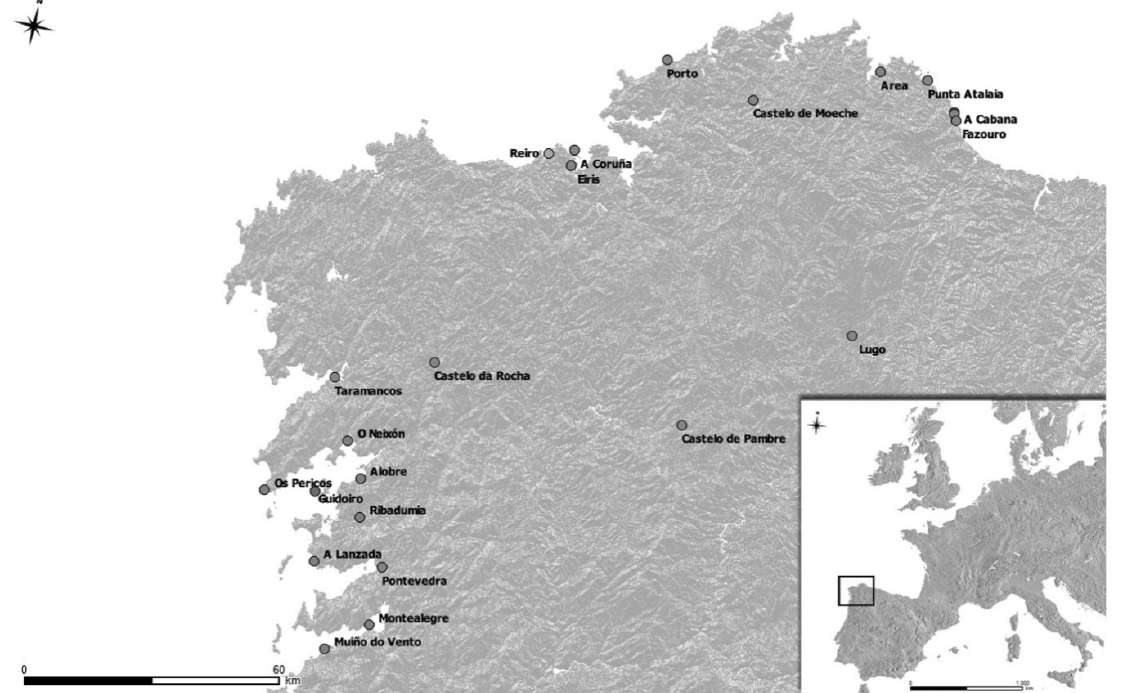
Figure 1. Location of Galicia within the Iberian Peninsula with indication of the coastal (i.e., marine and fluvial) middens our group studied over the past two decades.